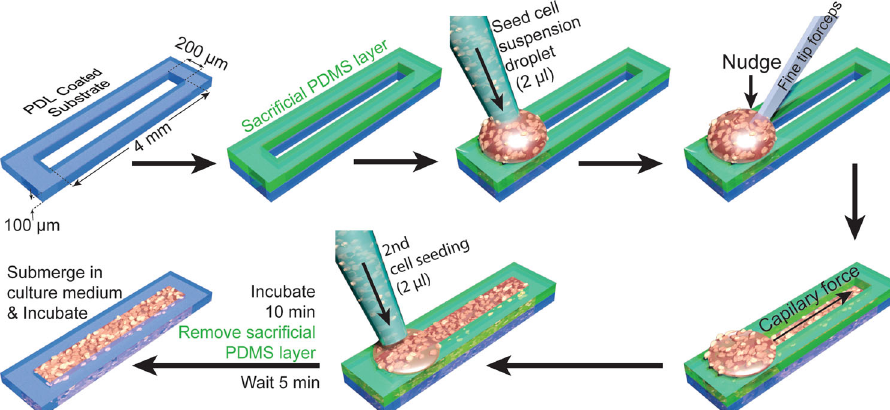
Fig. 1 Work fl ow for creating linear 3D cultures. PDMS device with slit is cut out from a 100 μ m high PDMS fi lm and plated on cell culture substrate. An identical device is stacked on top of the base device. Dense cell suspension is then seeded at the edge of the slit. Cell suspension will not go in slit due to surface tension. A nudge with a fi ne forceps tip breaks surface tension and then slit ’ s capillary force pulls the cell suspension in. In total, 2 μ l cell suspension is again seeded at the previous spot to ensure complete fi lling of the slit. The device is then incubated for 10 min and sacri fi cial PDMS layer is removed. After another 5 min of incubation, the whole device is submerged with culture medium and maintained for up to 18 days as described in “ Methods ”